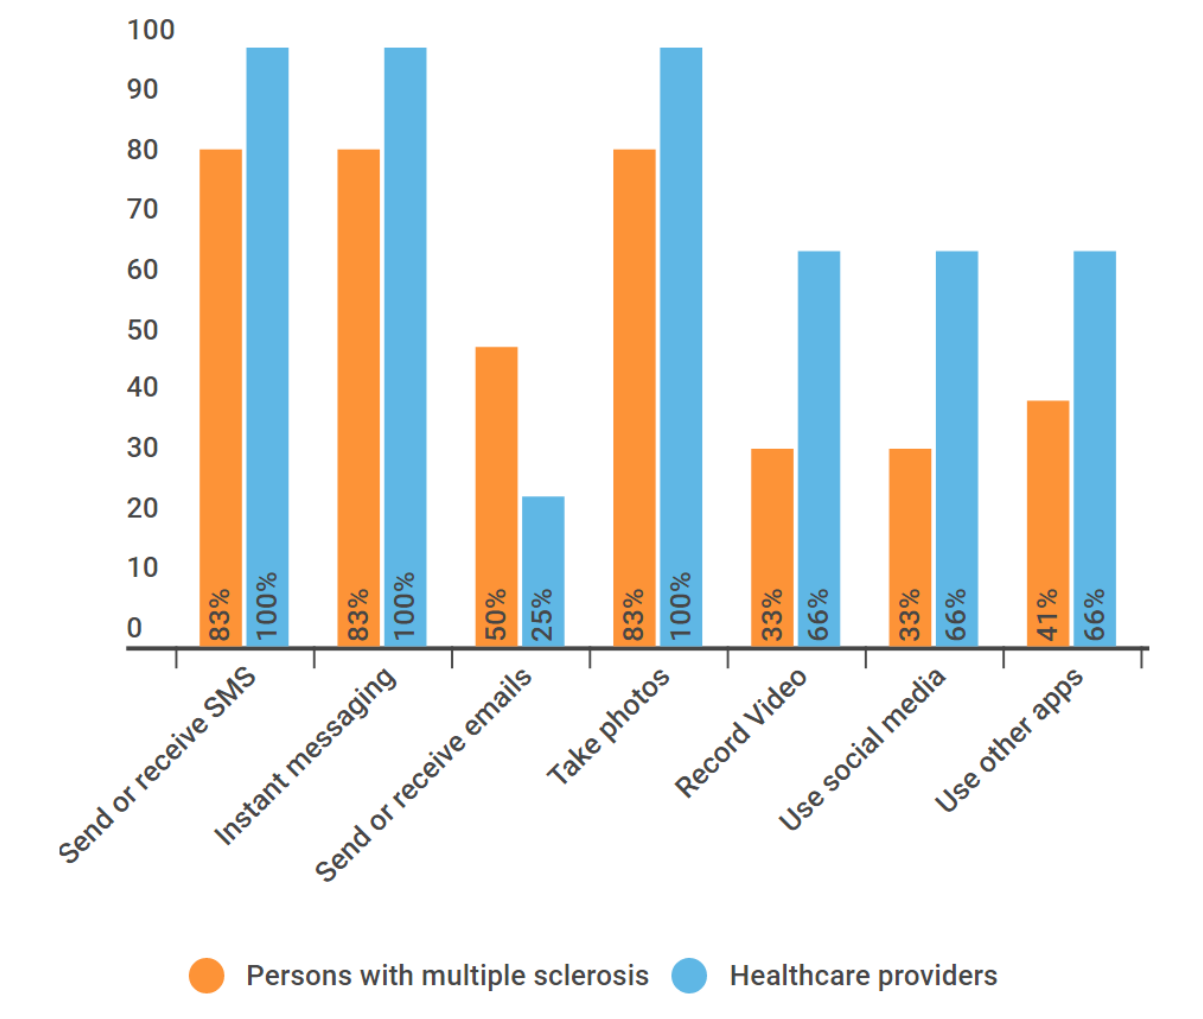
Figure 2. Mobile phone usage. SMS: short message